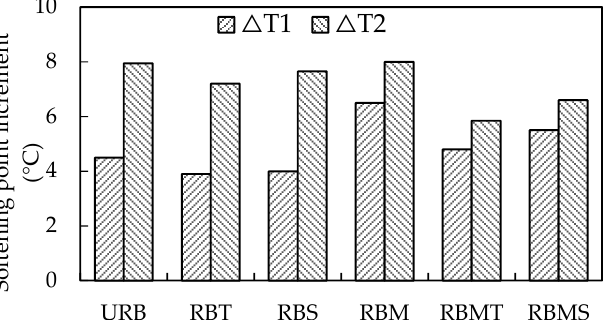
Figure 4. E ff ect of modification methods on the softening point increment of rubberized Figure 4. Effect of modification methods on the softening point increment of rubberized bitumen.